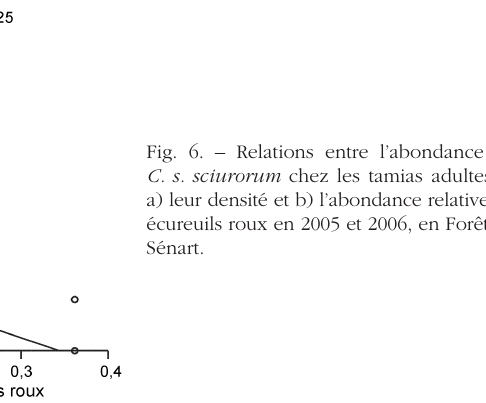
Fig. 6. – Relations entre l’abondance en C. s. sciurorum chez les tamias adultes et a) leur densité et b) l’abondance relative en écureuils roux en 2005 et 2006, en Forêt de